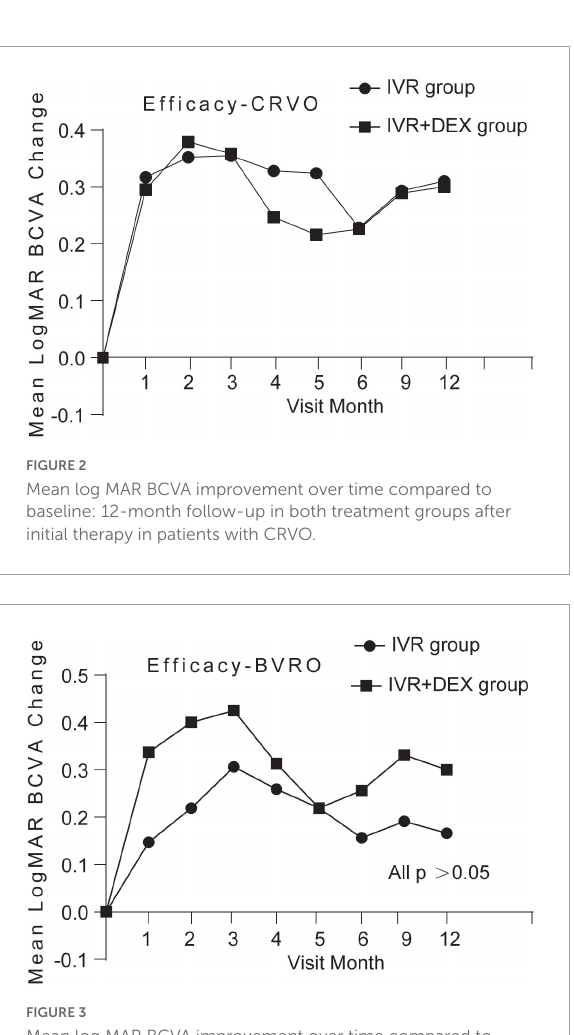
FIGURE5 CFT decreased over time compared to baseline: 12-month follow-up in both treatment groups after initial therapy in patients with BRVO.